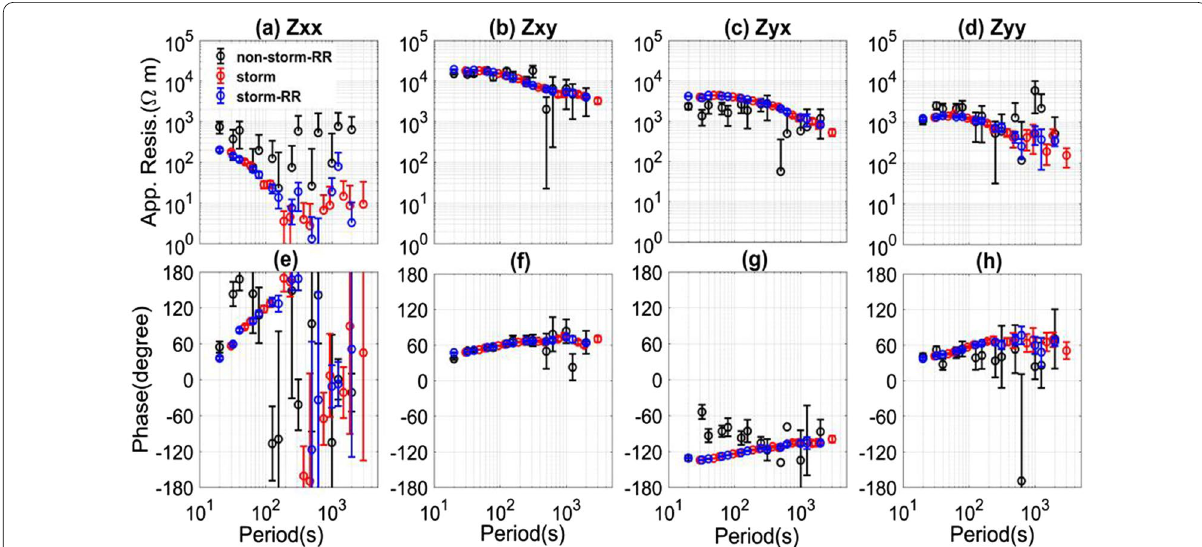
Fig. 9 Comparison of the MT sounding curves calculated by single-site and remote reference data processing using the storm and non-storm data observed at site 142. The black curves are calculated by the non-storm data with remote reference processing (non-storm-RR); the blue curves are calculated by storm data with remote reference processing (storm-RR); and the red curves are calculated by storm data with single-site data processing (storm). a – d Show the apparent resistivity. e – h Show the impedance phase. The horizontal axis denotes the period in